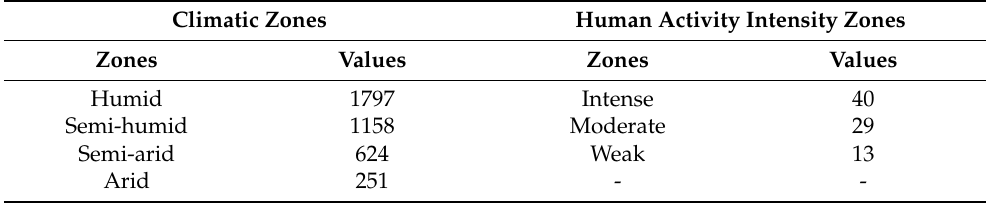
Table 2. Cluster values of precipitation (mm) in different climatic zones and human activity intensity index in different human activity intensity